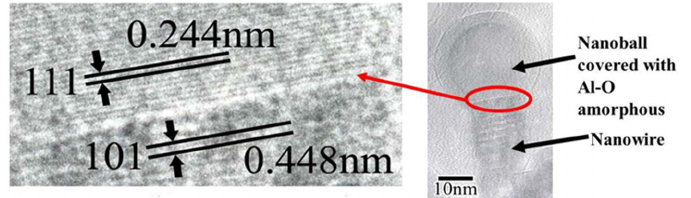
Figure 18. The interface of the θ -Al 2 O 3 nanowire and nanoball, shown in Figure 17, exhibits a (111)//(101) epitaxial relationship. The nanoball is covered with an amorphous Al-O layer [14].